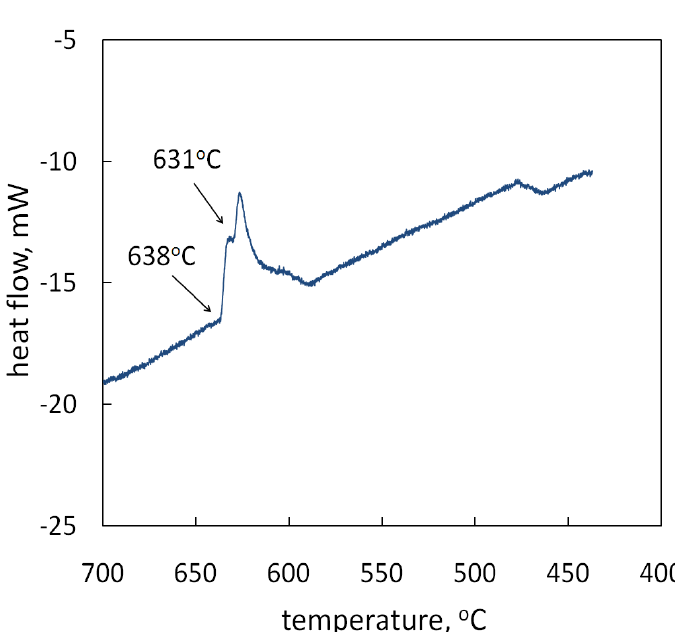
Figure 8. DSC curve of the